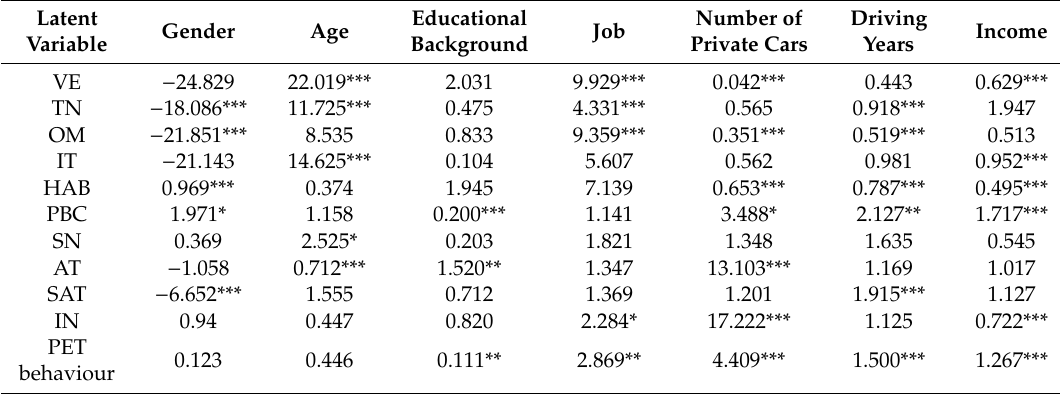
Table 6. Influence of socio-demographic characteristics on latent